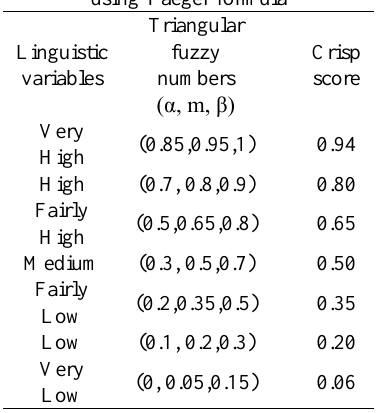
Table 2. Conversion of triangular fuzzy numbers to crisp scores